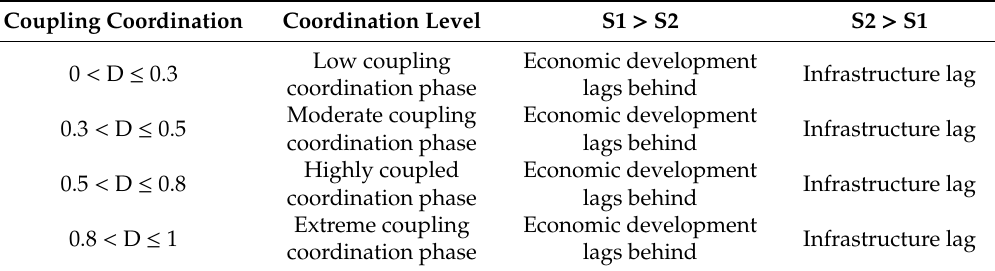
Table 2. Coordination level of coupling